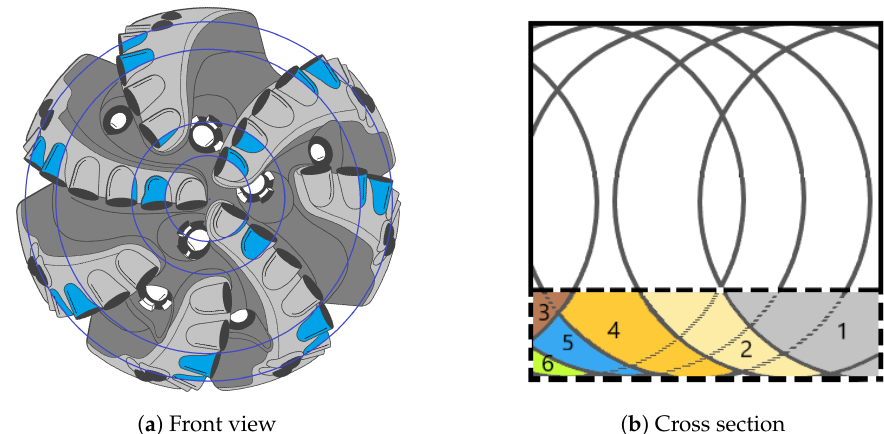
Figure 7. ( a ) The framework of equivalent rectangular cutters formed by the overlapping of complete or partial circular cutters and ( b ) schematic of an equivalent cutter composed of several partial